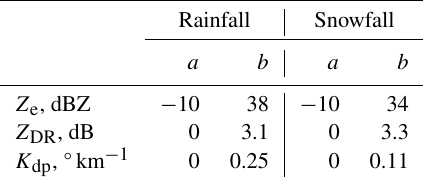
Table 1. Standardization of radar variables, [ a,b ] → [ 0 , 1 ] . Rainfall